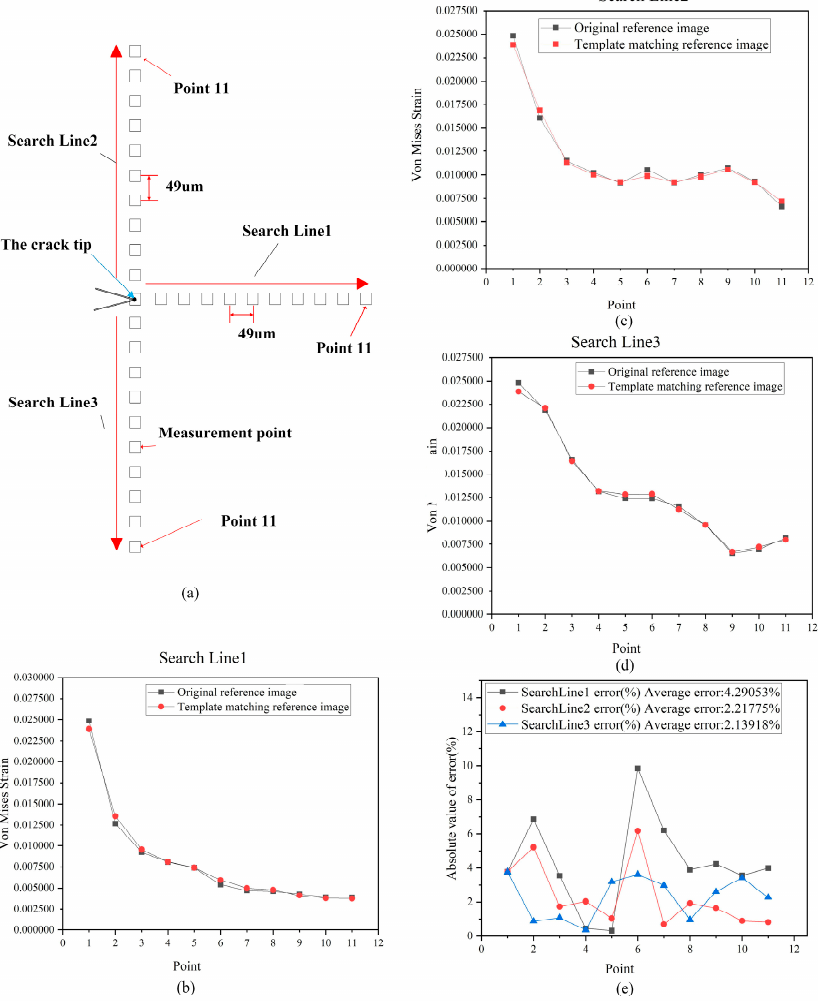
Figure 19. ( a ) Measuring point arrangement; ( b ) strain results of search line 1; ( c ) strain results of search line 2; ( d ) strain results of search line 3; ( e ) measurement error of three search lines.